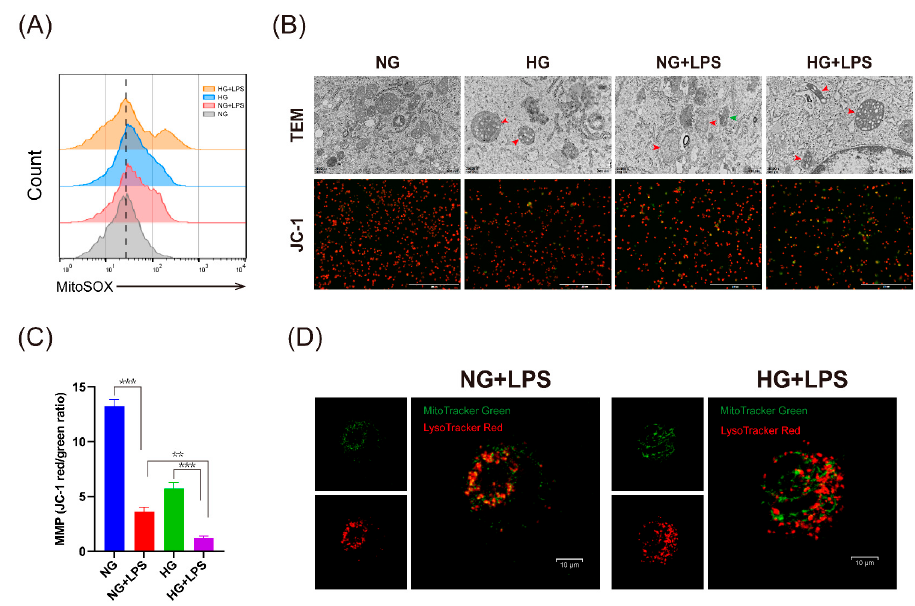
Figure 4. High glucose promoted ROS generation in macrophages stimulated by LPS. ( A – D ) THP-1 macrophages were cultivated in NG or HG medium for 24 h, and were then stimulated with or without LPS (1 µ g/mL) for 24 h. ( A ) THP-1 macrophages were stained with mitoSOX and analyzed by flow cytometry. ( B ) Transmission electron microscope (TEM) images (upper panel) of THP-1 macrophages (scale bar: 500 nm). The red arrow represents dysfunctional mitochondria and the green arrow represents autolysosome. JC-1 staining (lower panel) to detect mitochondrial membrane potential (MMP) in THP-1 macrophages (scale bar: 400 µ m). ( C ) Quantitative analysis of JC-1 using red/green ratio. ( D ) Macrophages were stained with MitoTracker Green and LysoTracker Red. The colocalization of mitochondria and lysosome dots were observed using confocal microscopy (scale bar: 10 µ m). ** p < 0.01. *** p < 0.001. TEM, transmission electron microscope; MMP, mitochondrial membrane potential.